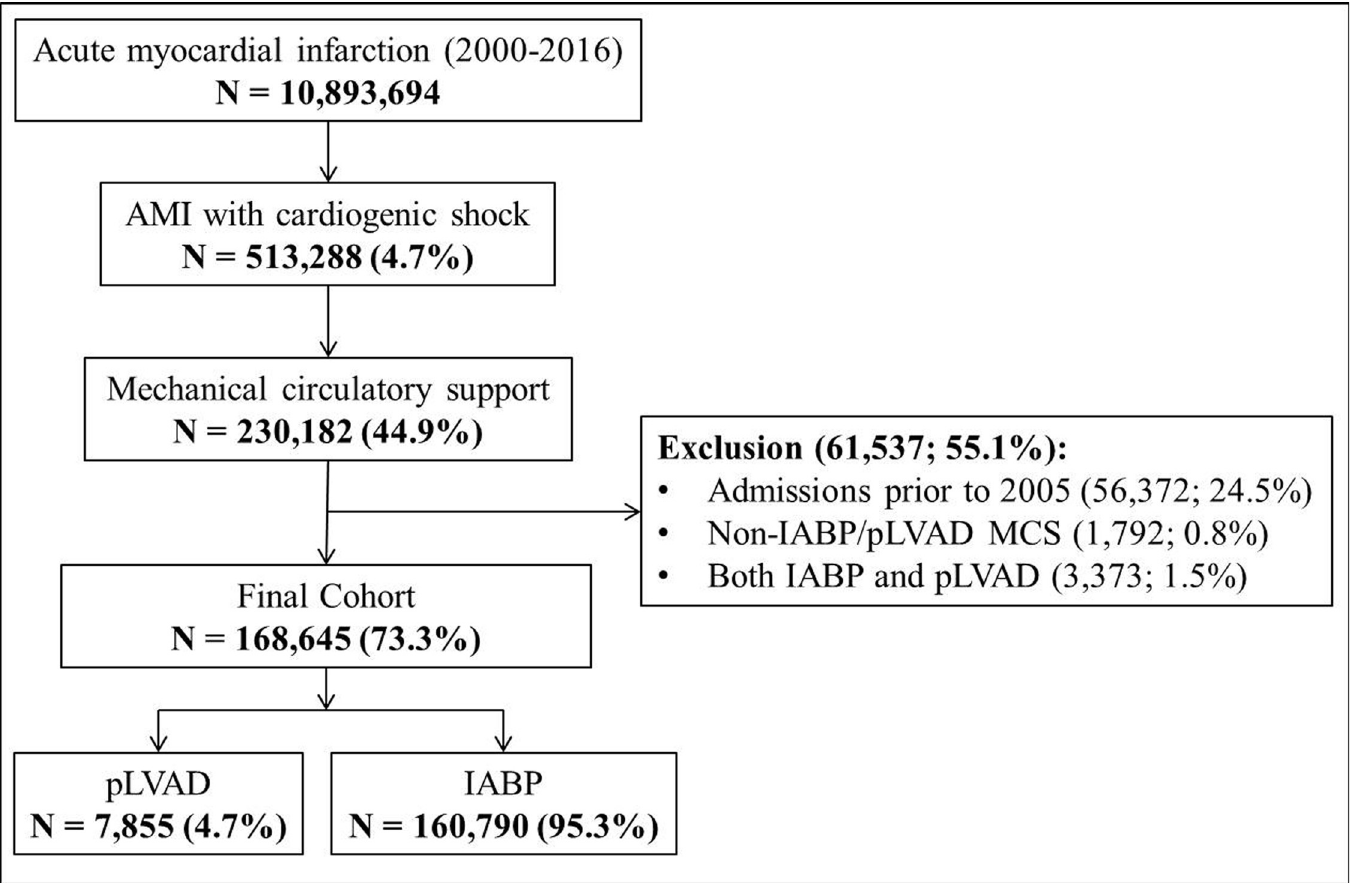
Fig 1. Consort diagram for selection of study cohort. Abbreviations: AMI: acute myocardial infarction; IABP: intra-aortic balloon pump; MCS: mechanical circulatory support; pLVAD: percutaneous left ventricular assist device.